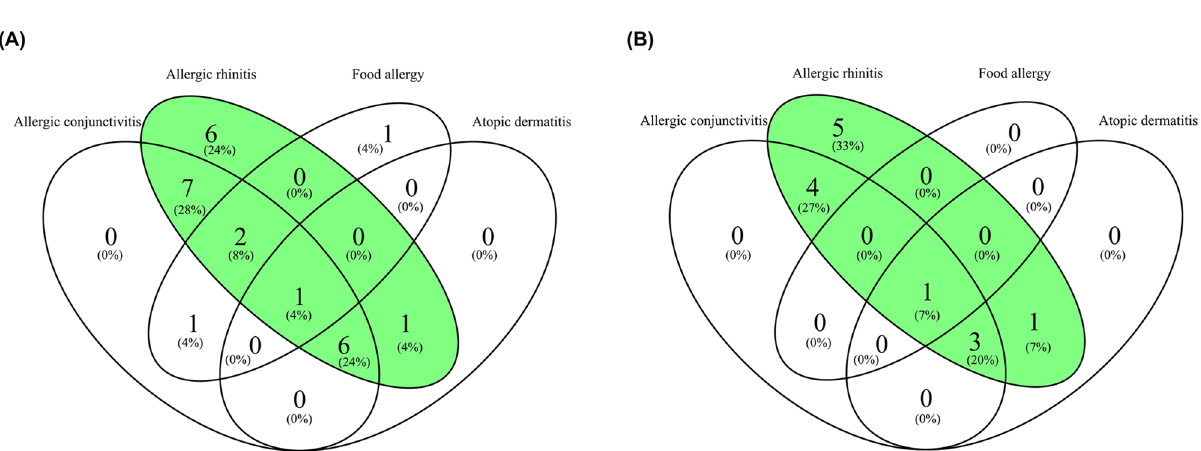
Figure 3. Study flow chart. Other atopic diseases include allergic rhinitis, atopic dermatitis, allergic conjunctivitis, food allergy or drug allergy.